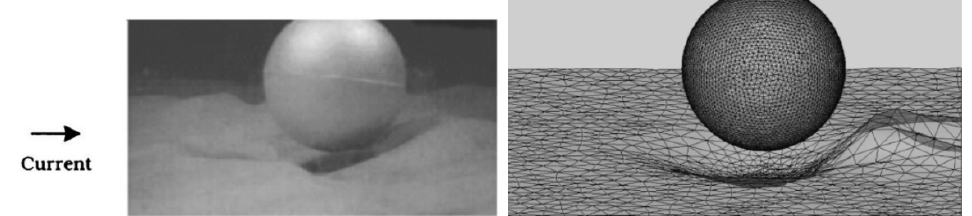
Figure 6. Illustration of the scour shapes in the experiment and simulation, 𝜃 ∞ = 0.05.